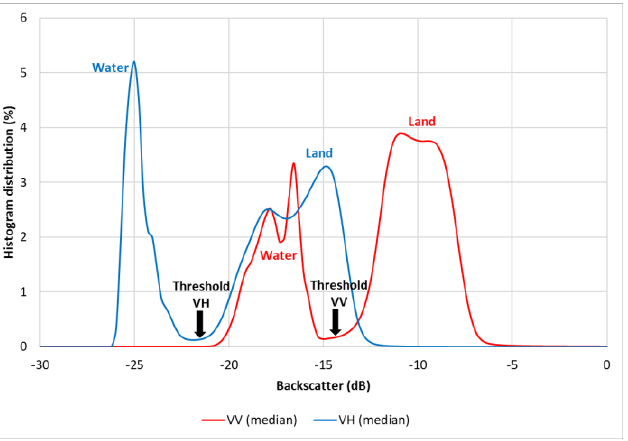
Figure 4. VV and VH backscatter histogram of a median image of a 1 year time series of Sentinel-1 images from a Norwegian coastal area including water and land.